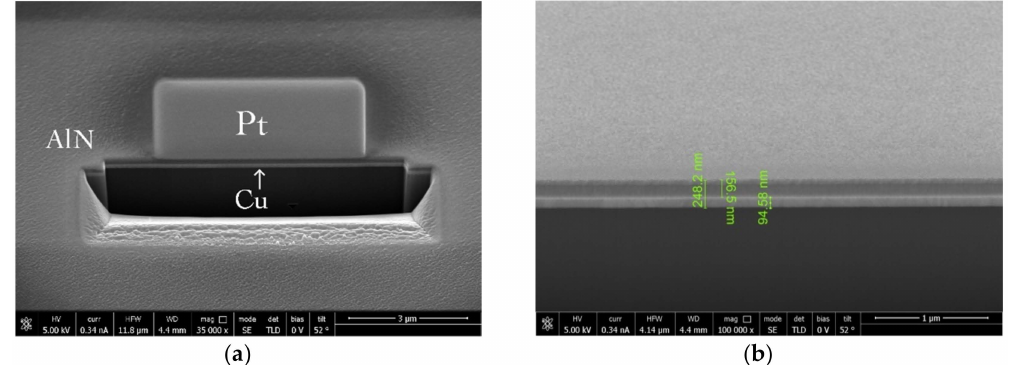
Figure 2. ( a ) Scanning electron microscope (SEM)scan showing the cross-section of bilayer design. Grey area on the top of aluminum nitride (AlN) film is a Pt deposition used to protect layers while milling with focused ion beam (FIB). ( b ) Cu (about 100 nm) and AlN (about 150 nm) layer thicknesses deposited on a test SiO 2 substrate. The measured thicknesses are corrected for the